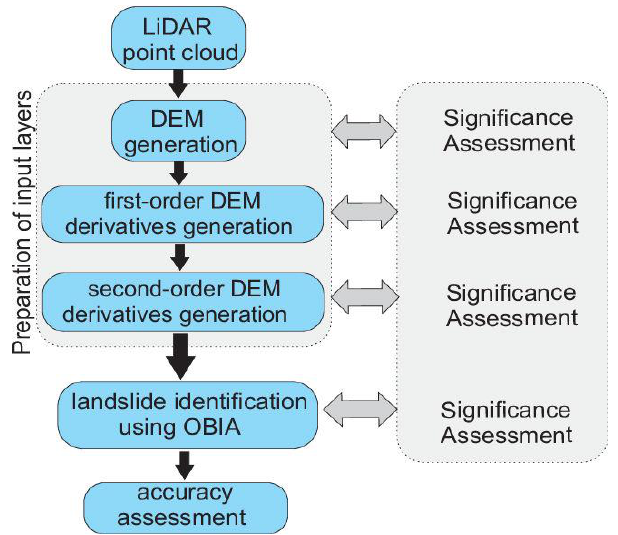
Figure 3. Overall methodology flowchart. Landslide identification using object-based image analysis (OBIA) was performed after preparation of input layer and significance assessment of various aspects. Detailed OBIA methodology is presented in Figure 4.